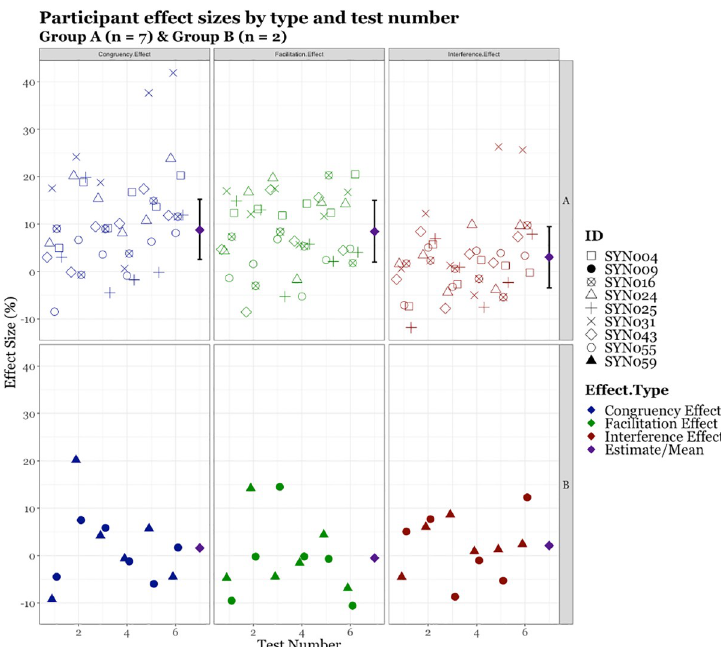
Fig 5. Participant effect sizes by test, type, and group with model estimates for subgroup A and